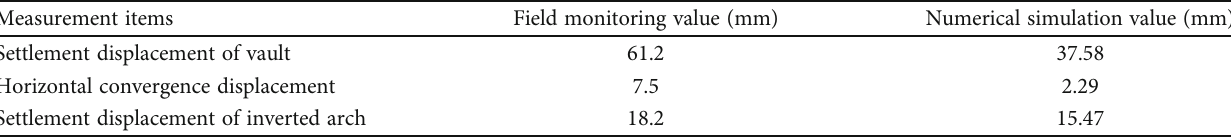
Figure 14: Pressure-time curve of surrounding rock. Table 5: Field monitoring value and numerical simulation